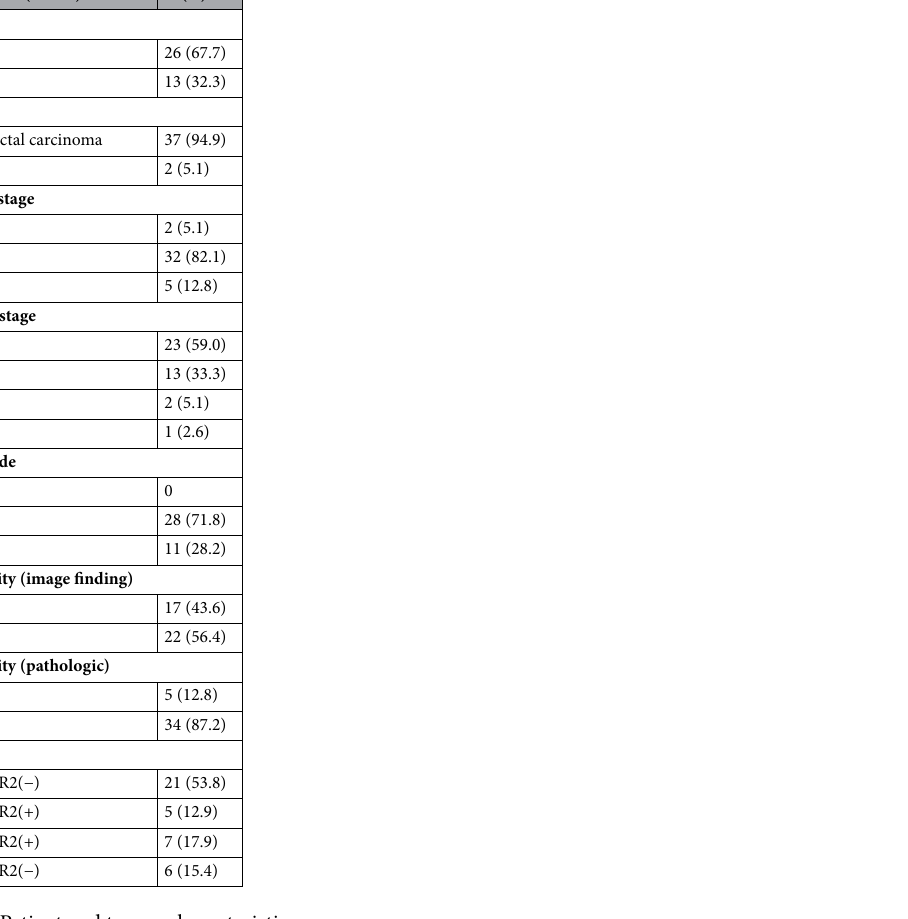
Table 1. Patient and tumor